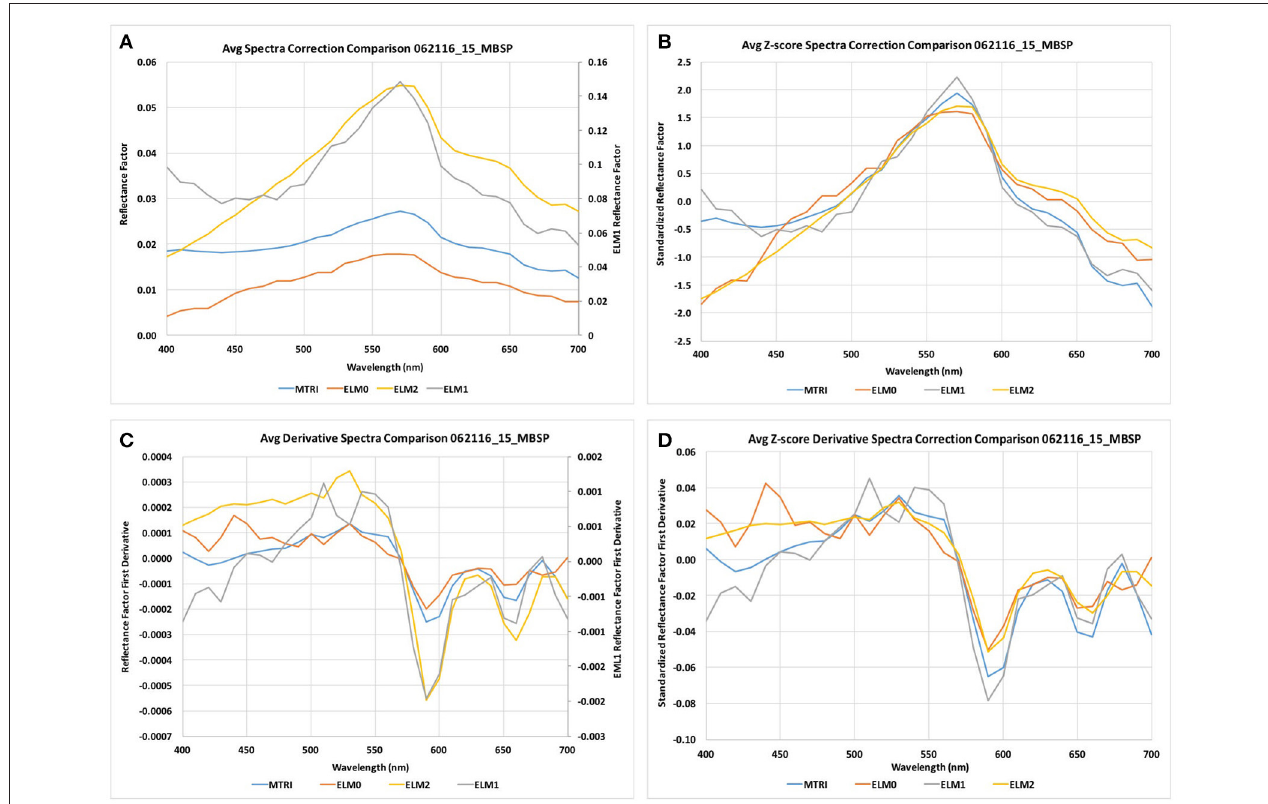
FIGURE 7 | (A) Comparison of average scene spectra for each correction method. (B) Comparison of z -score correction of average scene spectra. (C) Comparison of average derivative scene spectra for each correction method. (D) Comparison of z -score correction of average derivative scene spectra for each correction method.